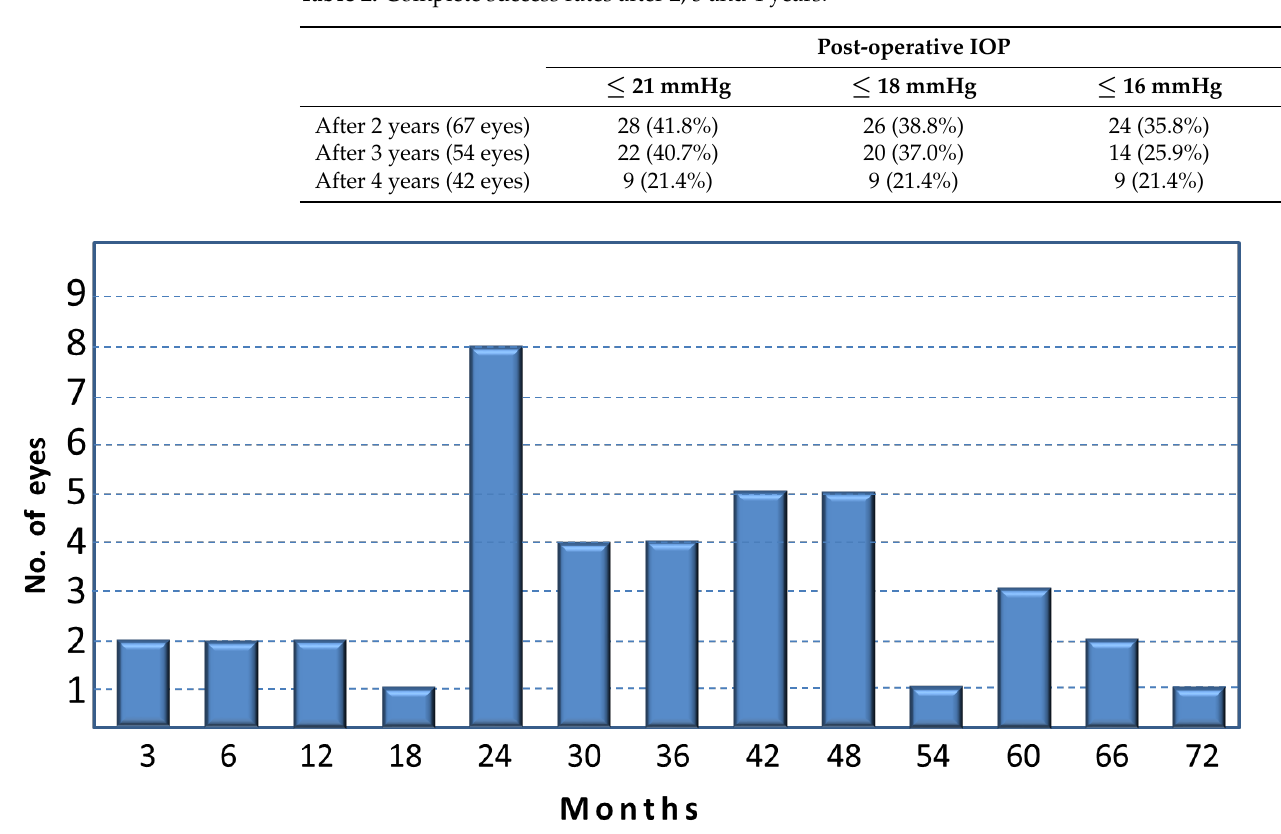
Table 2. Complete success rates after 2, 3 and 4 years.